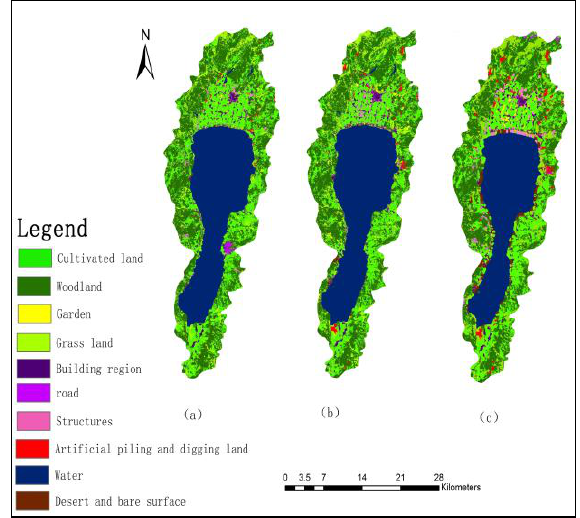
Figure 3. The map of land use type ((a) 2006, (b) 2014, (c) 2022